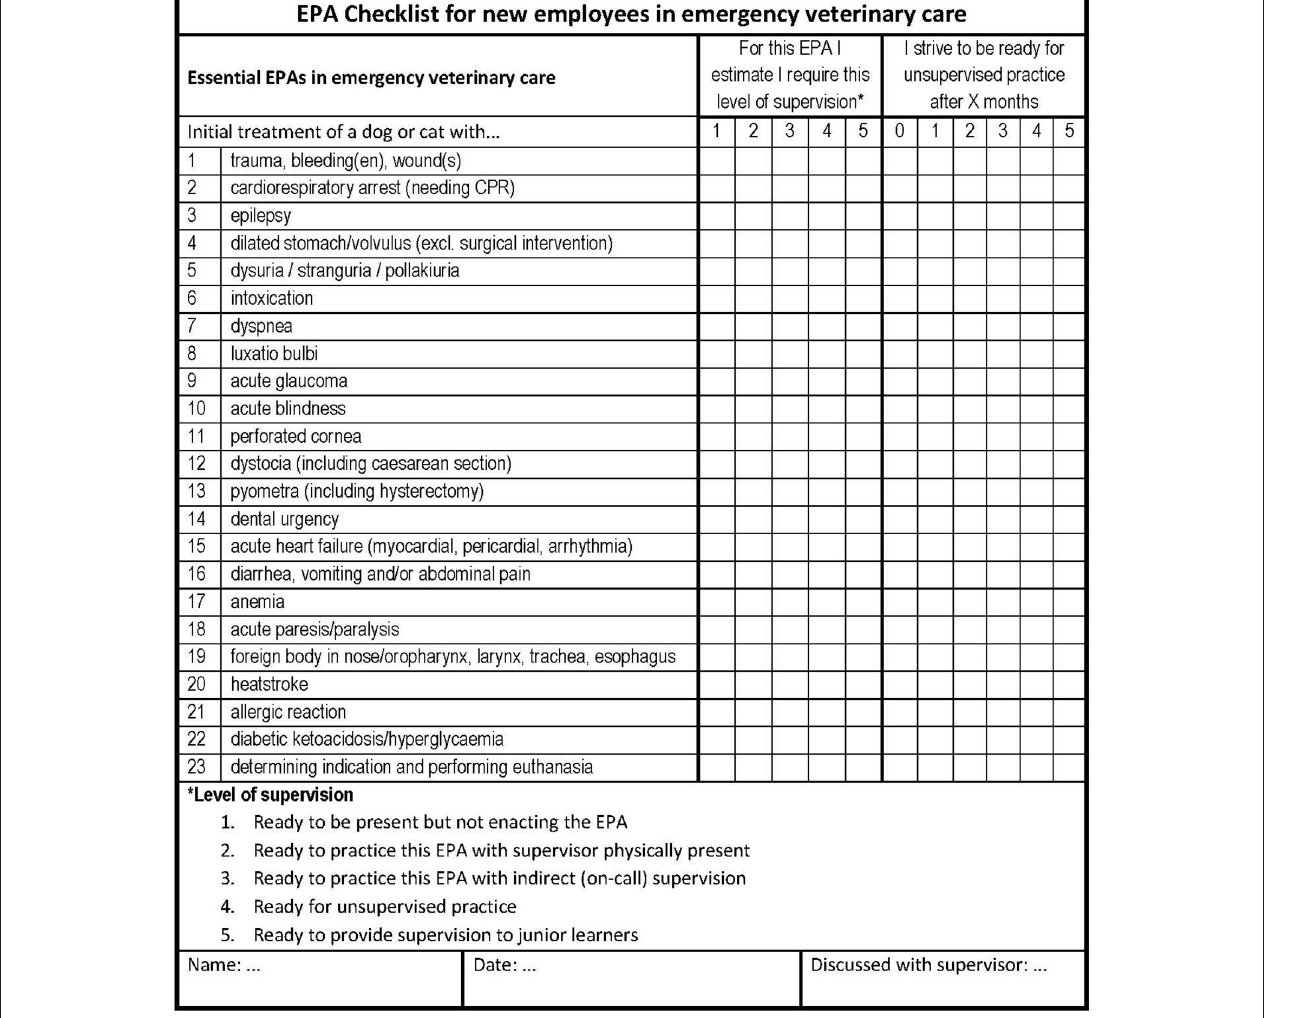
Frontiers in Medicine |